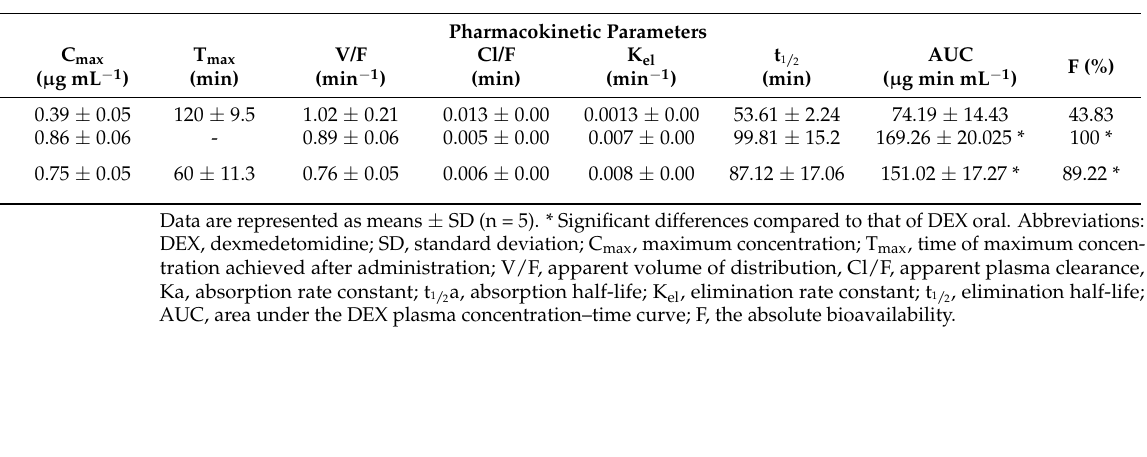
Table 4. Calculated pharmacokinetic parameters for DEX in plasma after sublingual administration of F3 compared to oral and IV of